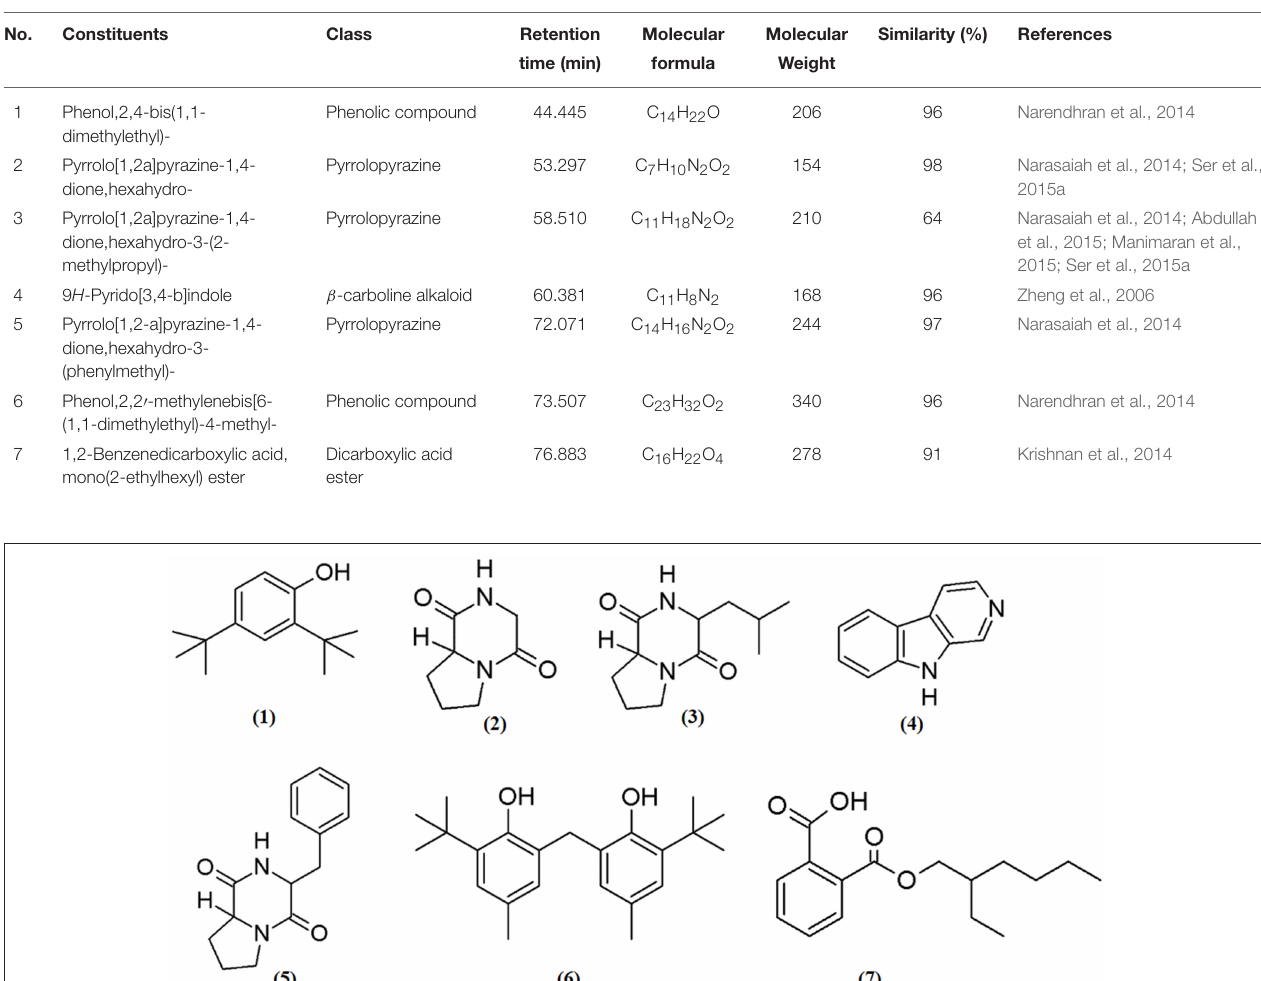
TABLE 2 | Chemical constituents identified in of Streptomyces sp. MUM256 extract. No.